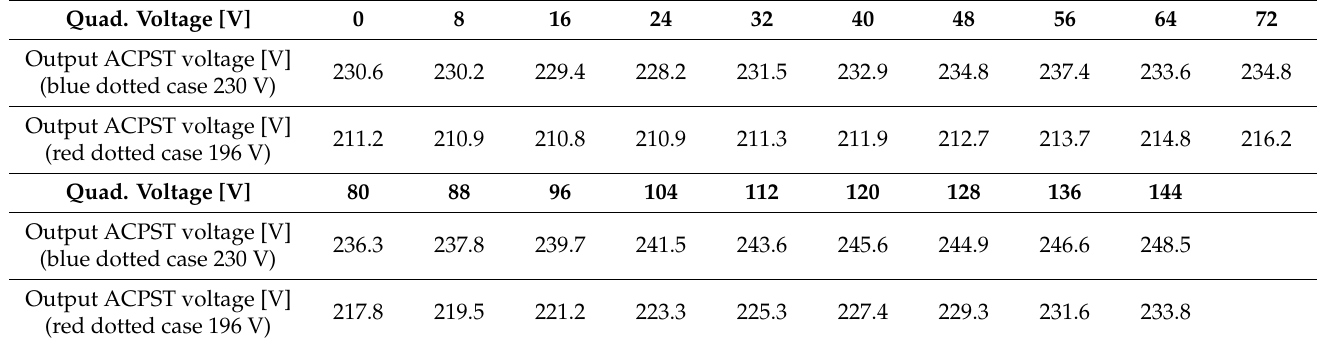
Table 4. The ACPST output voltages for 230 V and 196 V longitudinal voltages.